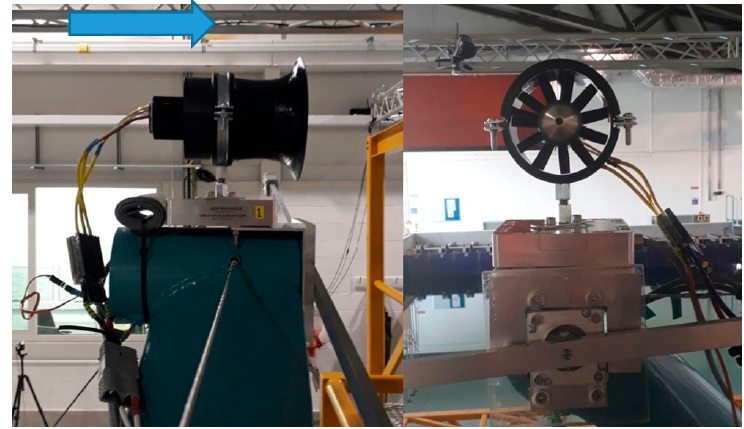
Figure 3. Nacelle configuration during testing. Wind direction indicated by blue arrow.